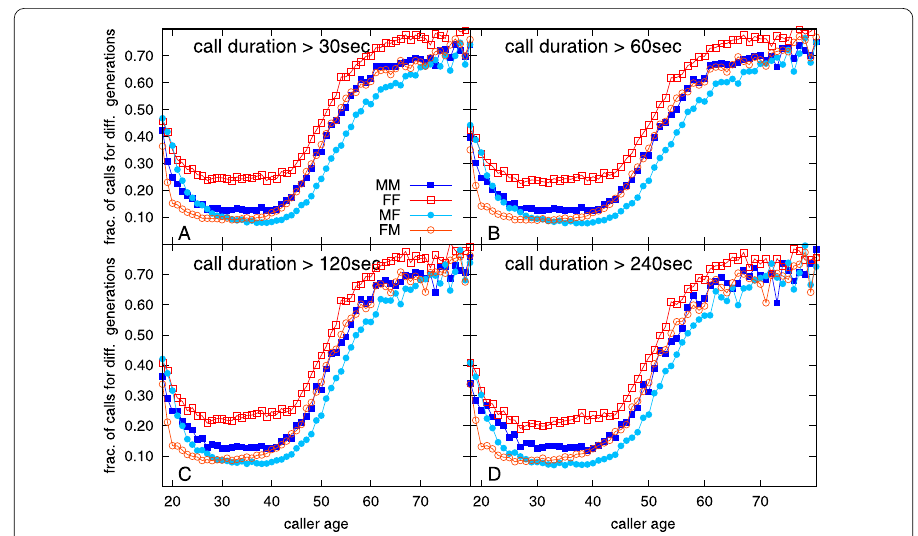
Figure 5 Fraction of calls from the callers to previous or to next generation callees as a function of caller’s age for the same and different gender pairs. The caller–callee pairs with a generation gap are chosen such that the magnitude of the difference between the ages of the caller and the callee is greater than 20 years. The normalization is such that the fraction of calls to caller’s own generation and fraction of calls to the other generations sums up to